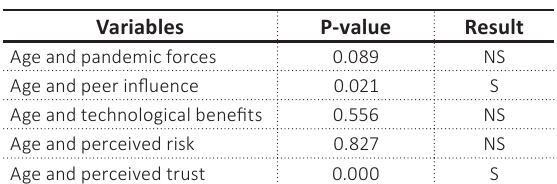
Table 5. Difference between age and the core